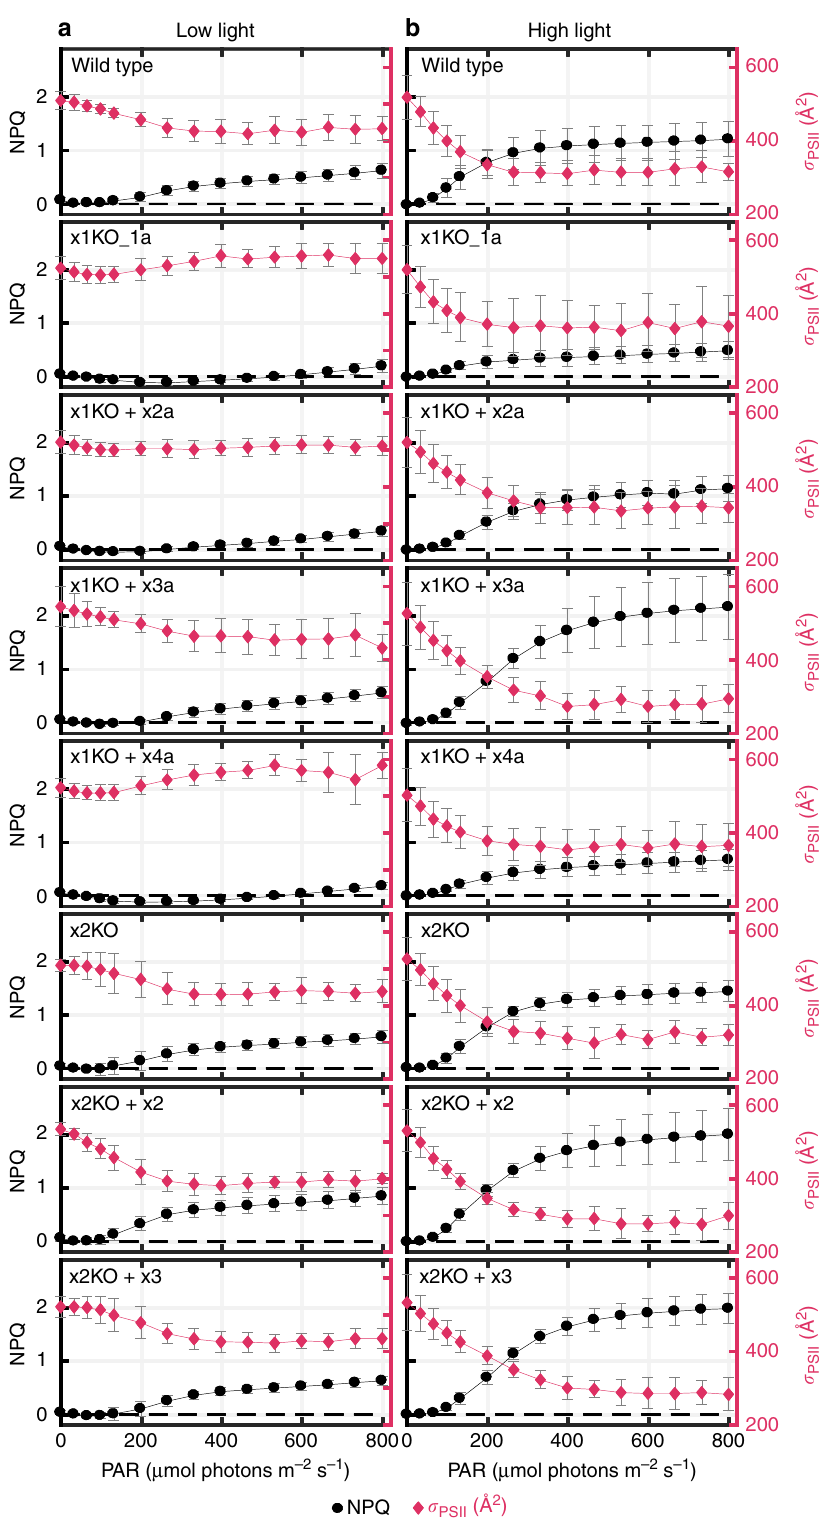
Fig. 4 NPQ development and changes in σ PSII during increasing light intensities. Wild-type and mutant strains cultivated under low light ( a ) and 24 h of high light ( ~ 400 µ mol photons m − 2 s − 1 ) ( b ) were exposed to 15 steps of increasing light intensity (1 min duration each), and NPQ (black trace) and σ PSII (red trace) were recorded. Values are the mean of six (low light cultures) or fi ve (high light cultures) biological replicates. SD is given. Dashed black line denotes zero NPQ. Source data are provided as a Source Data fi